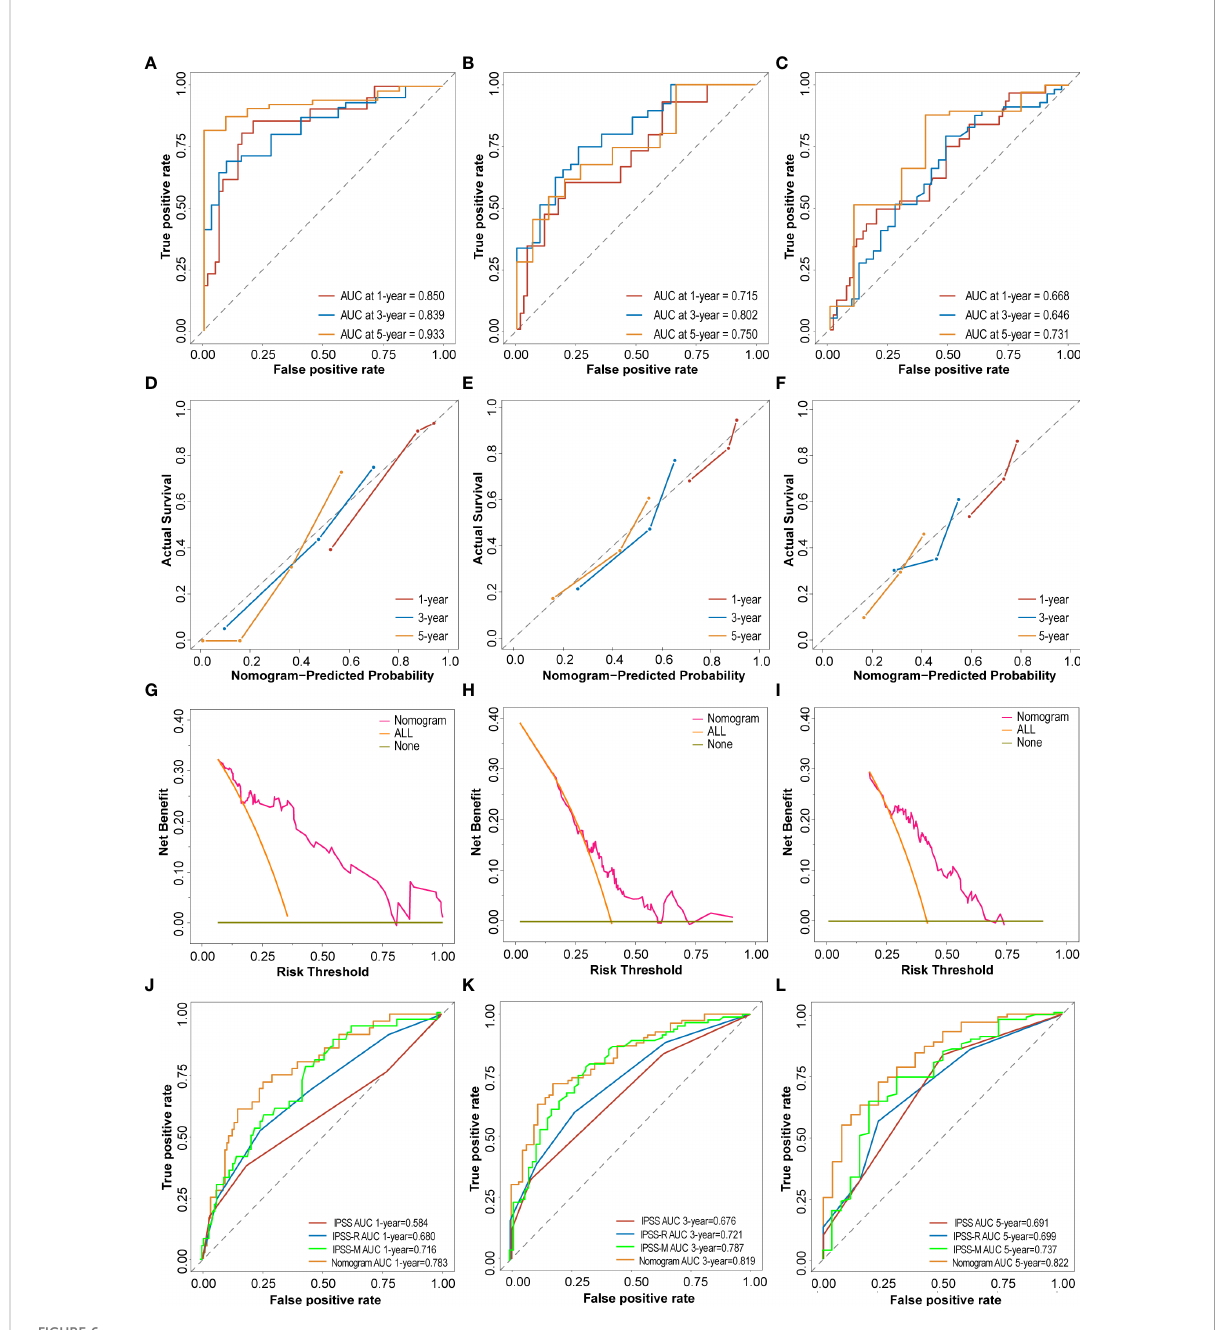
FIGURE 6 Performance and validation of the Nomogram. (A – C) The time-dependent receiver operating characteristic (ROC) curve and the area under the ROC curve (AUC) of nomogram at 1 year, 3 years and 5 years in the training cohort, testing cohort and external validation cohort. (D – F) The calibration plots of nomogram for predicting the 1 year, 3 years and 5 years in the training cohort, testing cohort and external validation cohort. (G – I) The Decision curve analysis (DCA) of nomogram for predicting the 5 years OS in the training cohort, testing cohort and external validation cohort. (J – L) ROC curves and the AUC of IPSS score, IPSS-R score, IPSS-M score and nomogram at 1 year, 3 years and 5 years in the entire GEO